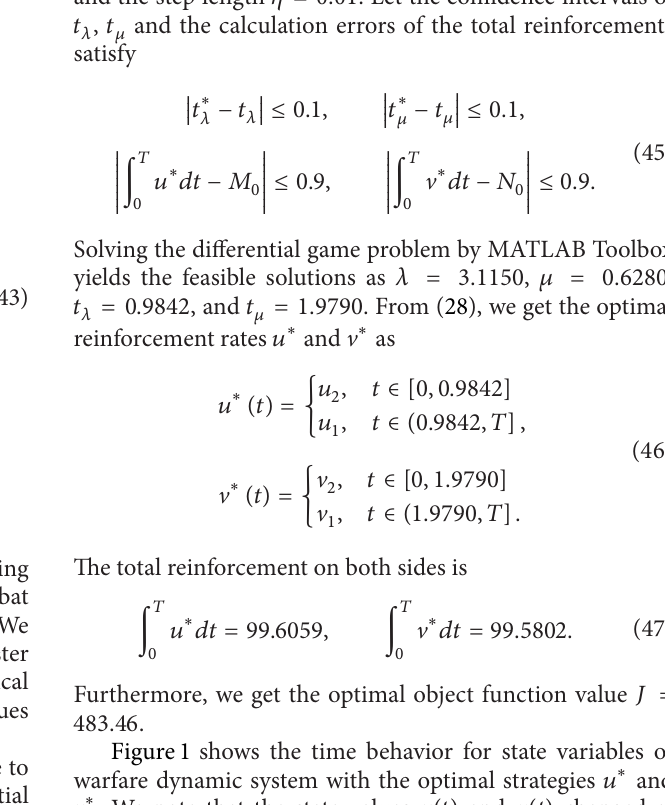
Figure 3: Changes of 𝐽(𝑢, V ) with the different reinforcement rate V for 𝑌 .